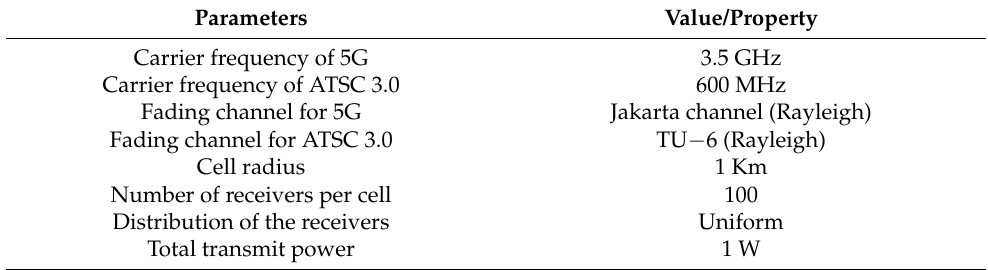
Table 4. The simulation